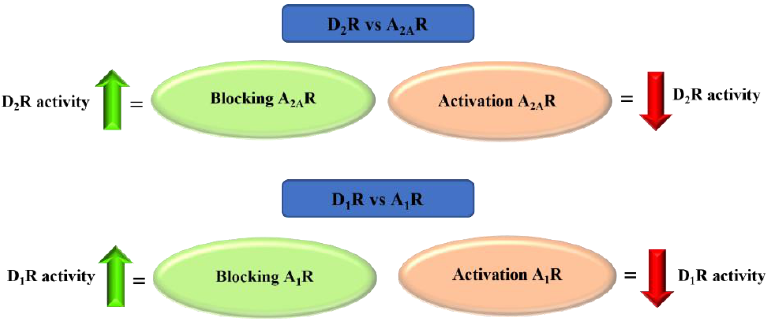
Figure 27. Adenosine A 2A and A 1 receptors—antagonism of action with dopamine D 2 and D 1 receptors.